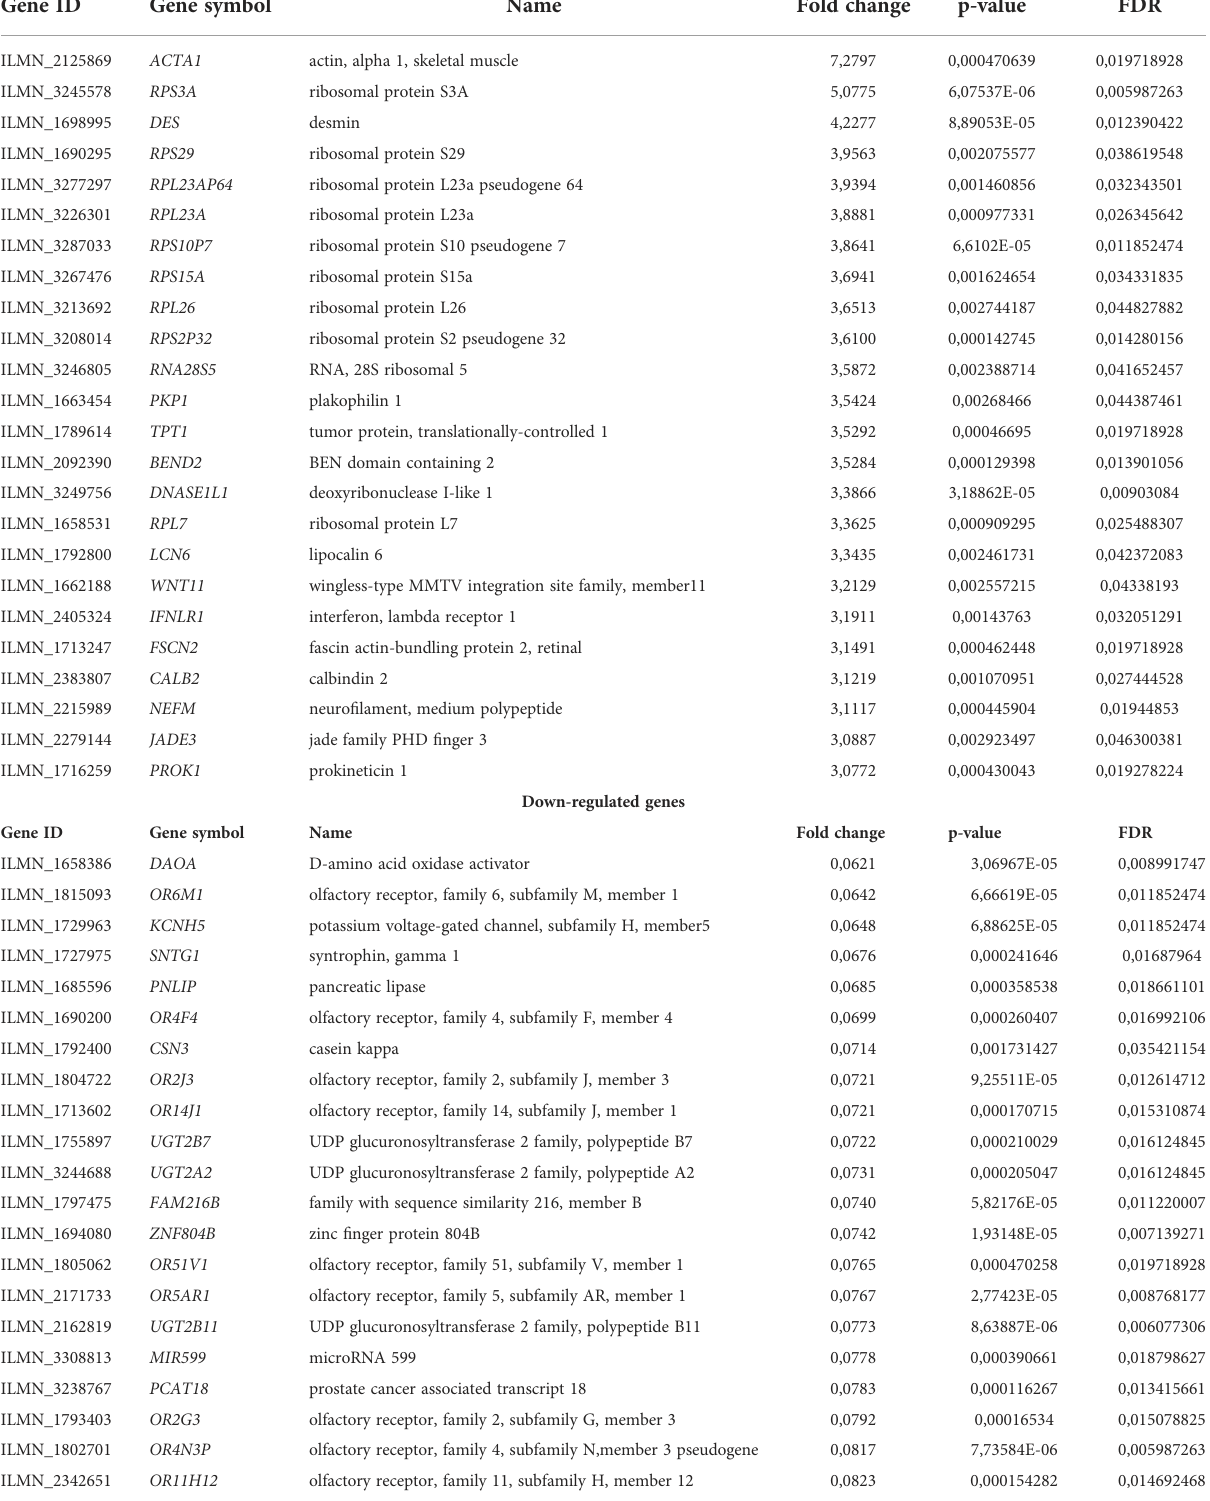
TABLE 3 Differentially expressed genes